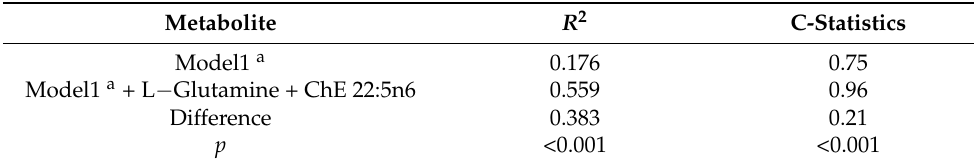
Figure 3. ( a ) Serum relative level of the L − Glutamine in SS and SR. t − test p value < 0.05 between the two group. ( b ) Serum relative level of the ChE 22:5n6 in SS and SR. t − test p value < 0.05 between the two group ( c ) Receiver Operating Characteristics plot of the model. Table 4. Comparison of R 2 and C-statistics before and after addition of identified SS metabolites.